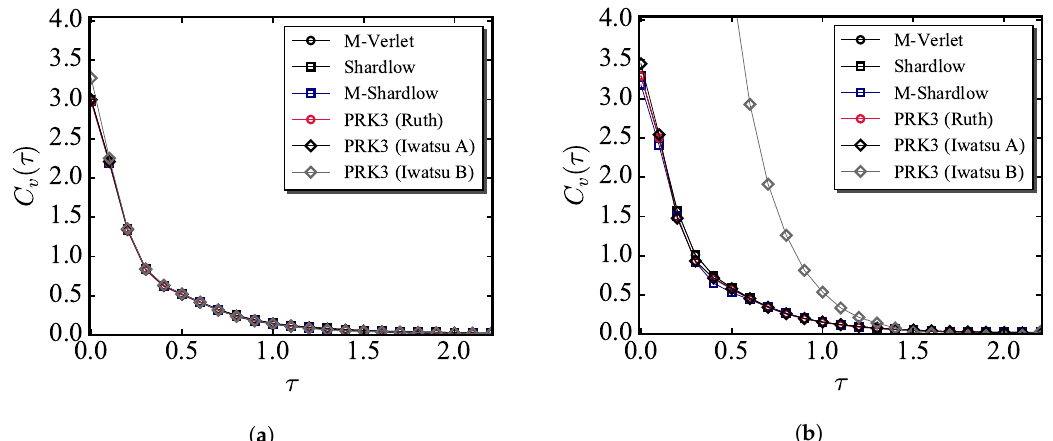
Figure 5. Velocity autocorrelation function as a function of delay time on different time integration schemes for ( a ) ∆ t = 0.005 and ( b ) ∆ t = 0.1.